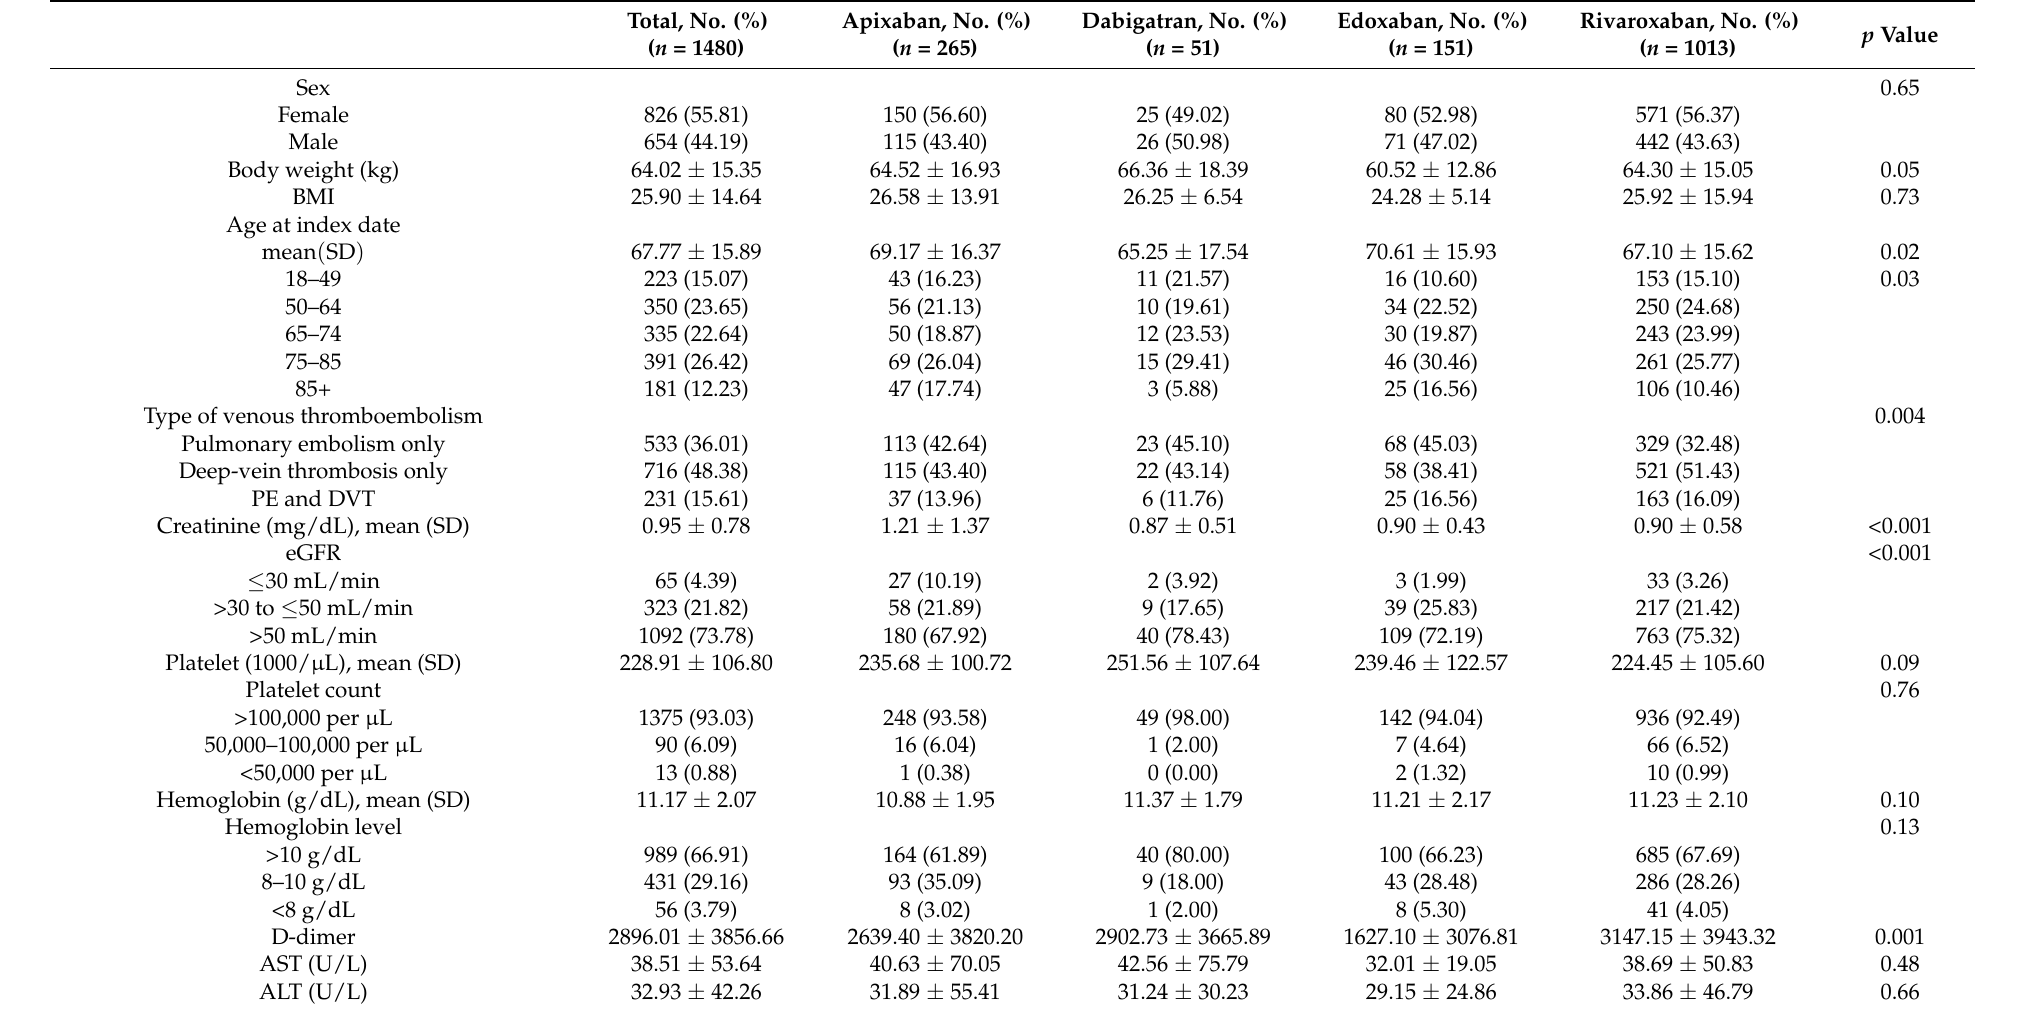
Table 1. Baseline demographics and clinical characteristics of patients with VTE treated with